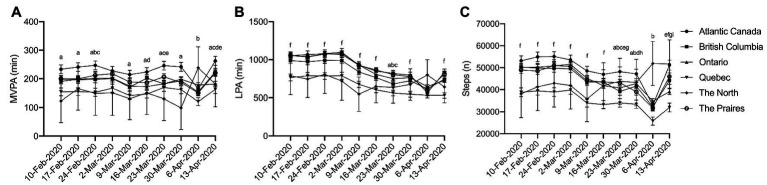
Physical activity during physical distancing by region. (A) MVPA; (B) LPA; (C) Steps; (a) Quebec is significantly different from Atlantic; (b) Quebec is significantly different from Ontario; (c) Quebec is significantly different from The Prairies; (d) Quebec is significantly different from British Columbia; (e) Atlantic Canada is significantly different from Ontario; (f) Quebec is significantly different from Atlantic Canada, British Columbia, Ontario, and The Prairies; (g) Atlantic Canada is significantly different from British Columbia; and (h) Atlantic Canada is significantly different from The Prairies. For clarity, only selected significant differences are indicated on the figure.